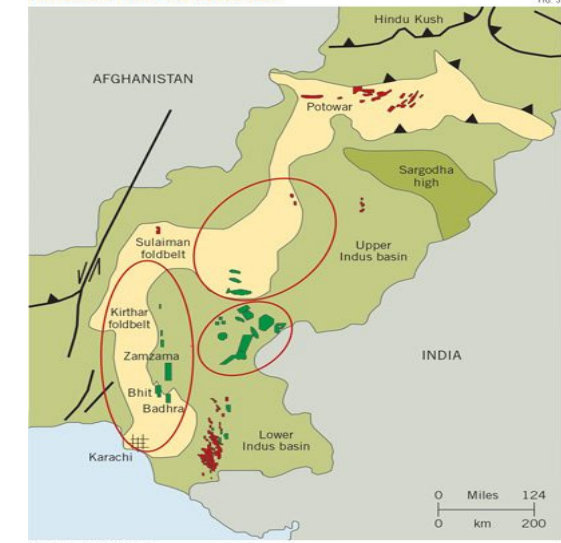
Fig. 4: Pakistan’s known Tight Gas Potential shown from Geological Perspectives, The Area on Map is encircled representing its existence in different basins